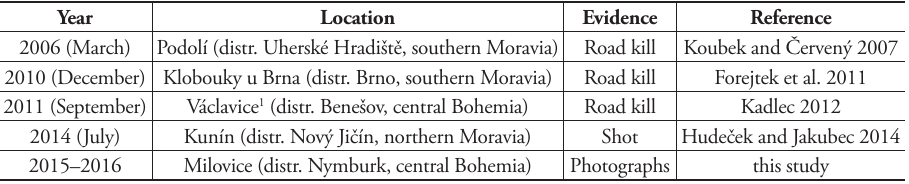
Table 1. Overview of verified published records of golden jackal ( Canis aureus ) in the Czech Republic. The records always refer to a single animal. Bohemia is the western and Moravia eastern part of the Czech Republic. See Fig. 1 for location of the